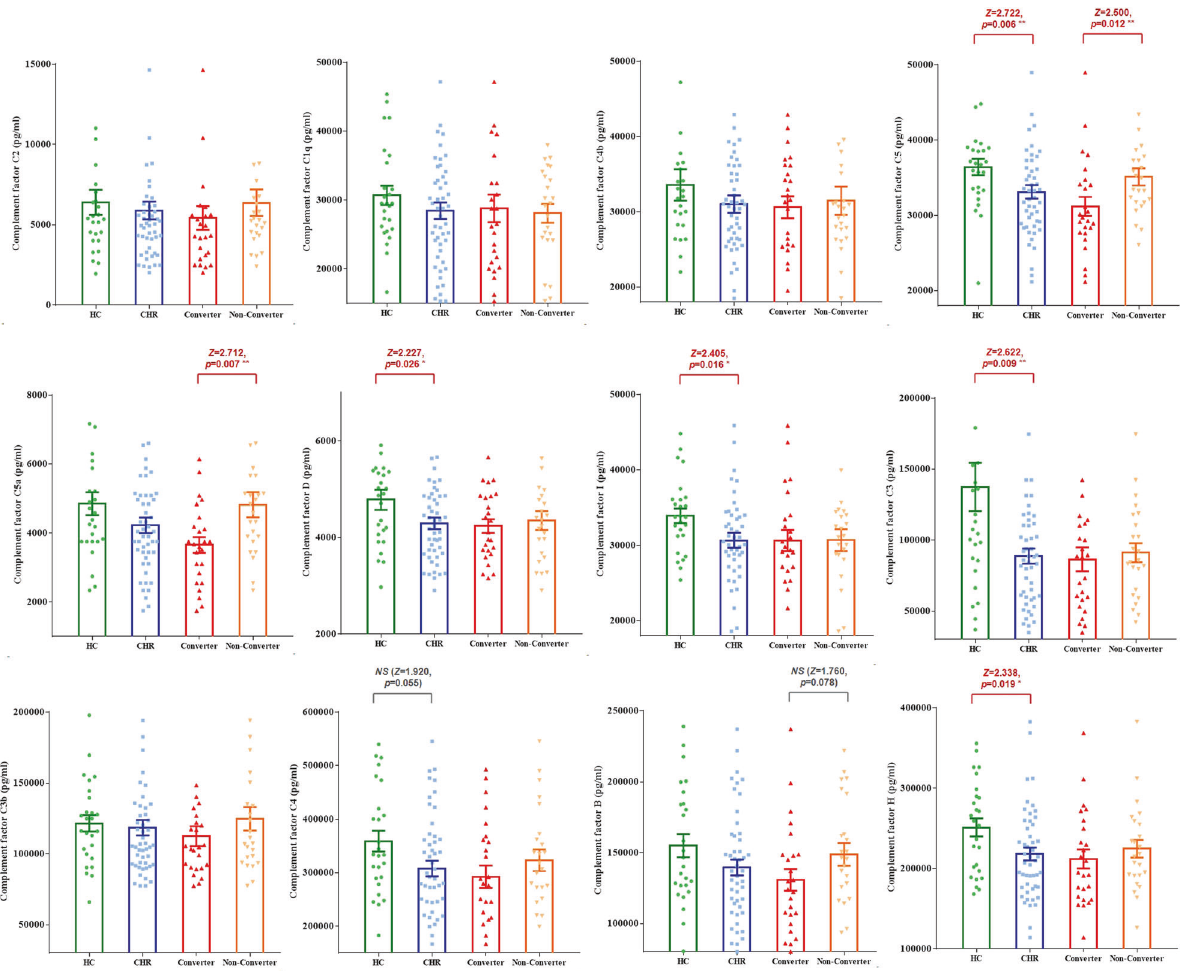
Fig. 2 Comparisons for serum levels of complement factors in HC and CHR individuals with converter versus non-converter. Bar shows the mean and standard error of complement factors. The Mann-Whitney U tests were performed for comparisons between groups. The level of statistical signi fi cance was set at a two-tailed P value of 0.05. Statistically signi fi cant p values are written above the bars. NS: non statistic signi fi cant. CHR Clinical high risk for psychosis, CHR-converter, CHR individuals who were converted to fully psychosis; HC Healthy control, * p < 0.05; ** p < 0.01; *** p <